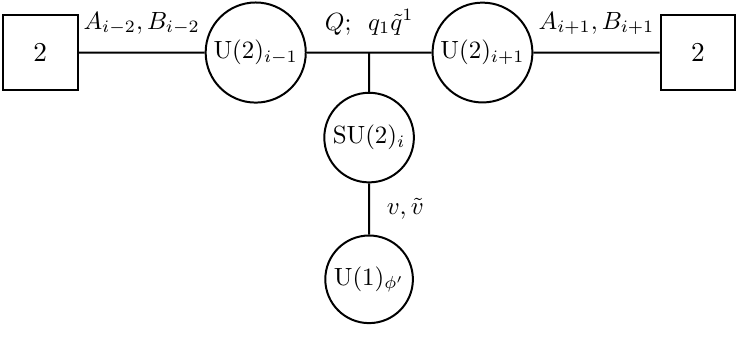
Figure 8 . Modified D N quiver (with φ 0 = φ + ϕ i − 1 + ϕ i +1 the scalar coupled to v, ˜ v ). In the diagram it is meant that Q is not charged under U(1) i ± 1 , while q 1 , ˜ q 1 are singlets under SU(2) i ± 1